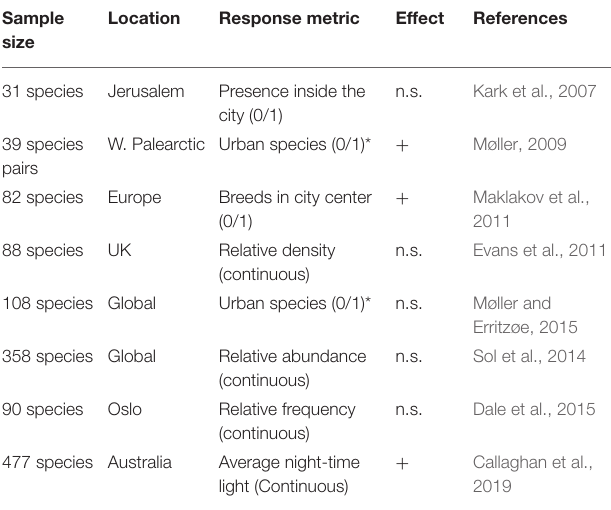
TABLE 1 | Summary of studies that have investigated the association between behavioral flexibility and urban tolerance in birds, in chronological order. Sample